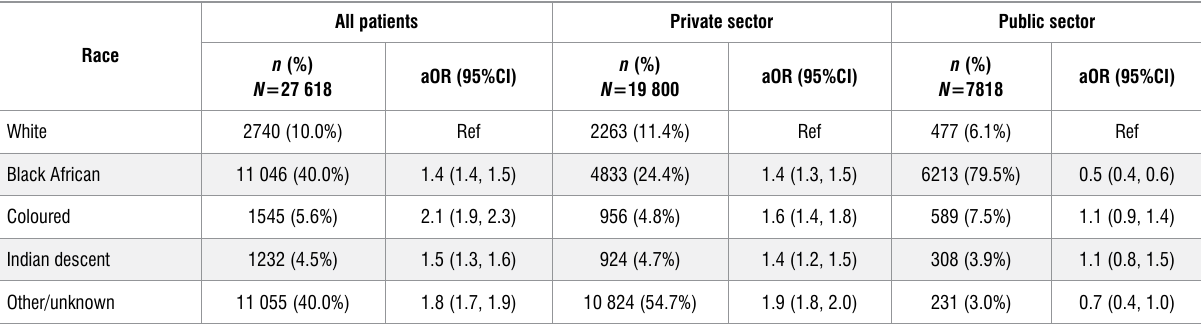
Factors associated with receiving invasive mechanical ventilation, among (1) all patients, (2) private sector patients, and (3) public sector,